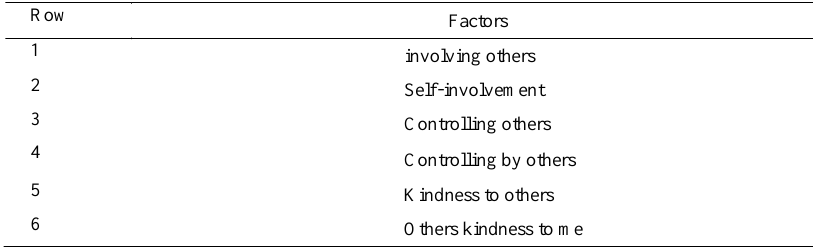
Table1: Questions factors